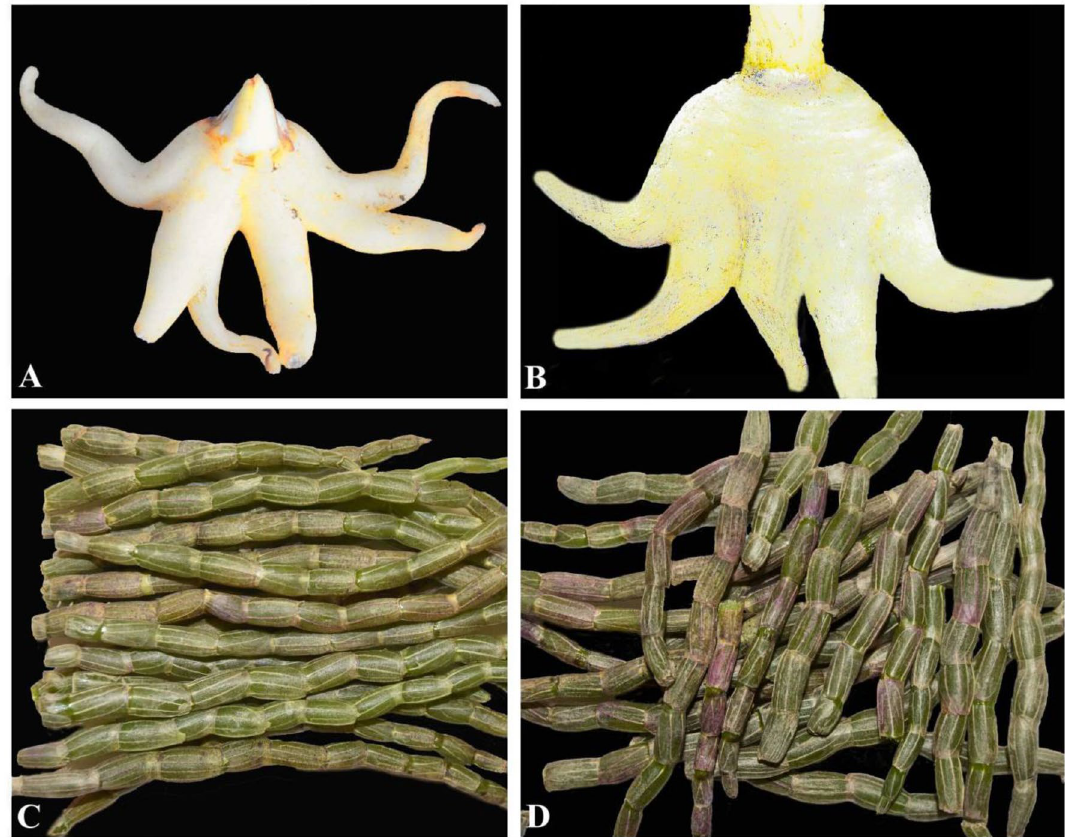
Figure 2. Tuber of Gymnadenia orchidis (A) and Dactylorhiza incarnata (B) , stems of Dendrobium officinale (C) and Dendrobium moniliforme (D) . Photographs by Bhakta B. Raskoti. Images merged in Adobe Illustrator CC v17.0. https:// www. adobe.